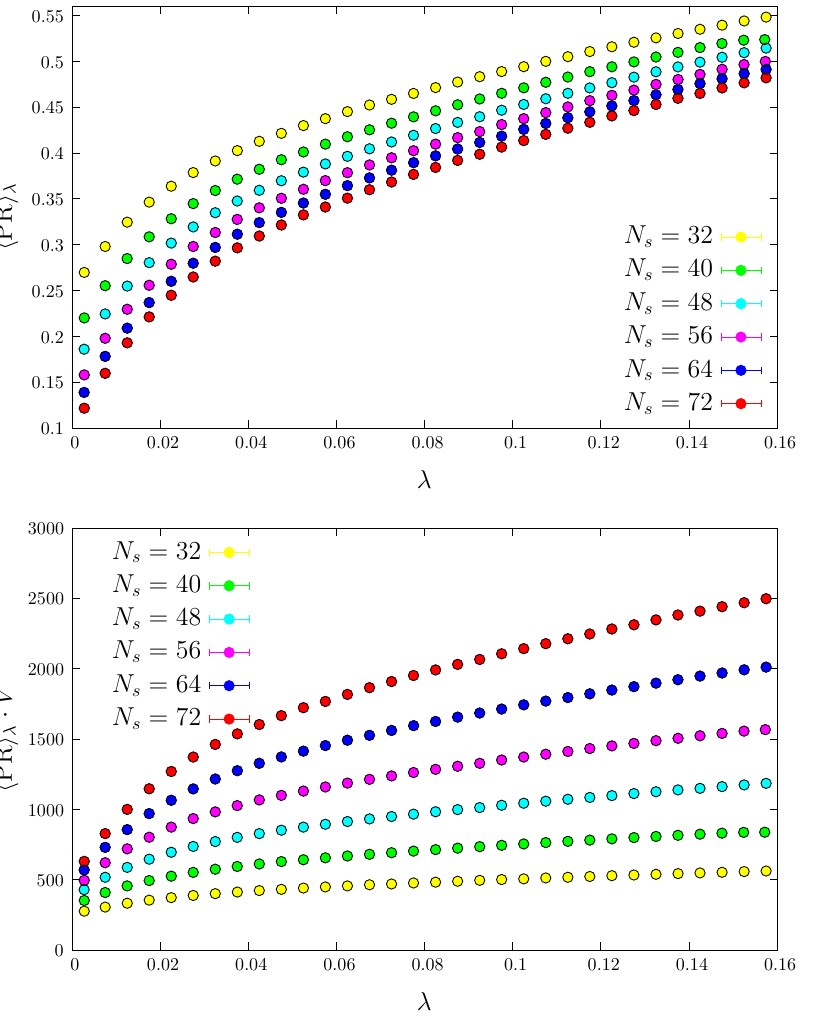
Figure 3 . Participation ratio ¯ β = 3 . 00 as a function of the spectral region for various